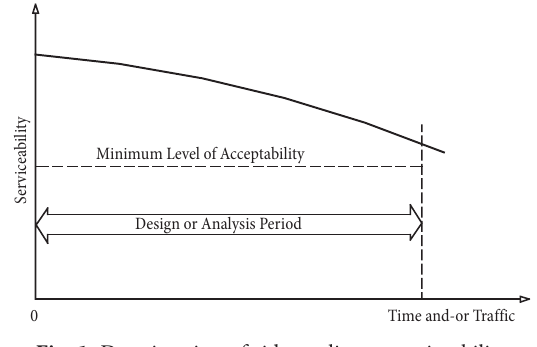
Fig. 1. Deterioration of ride quality or serviceability